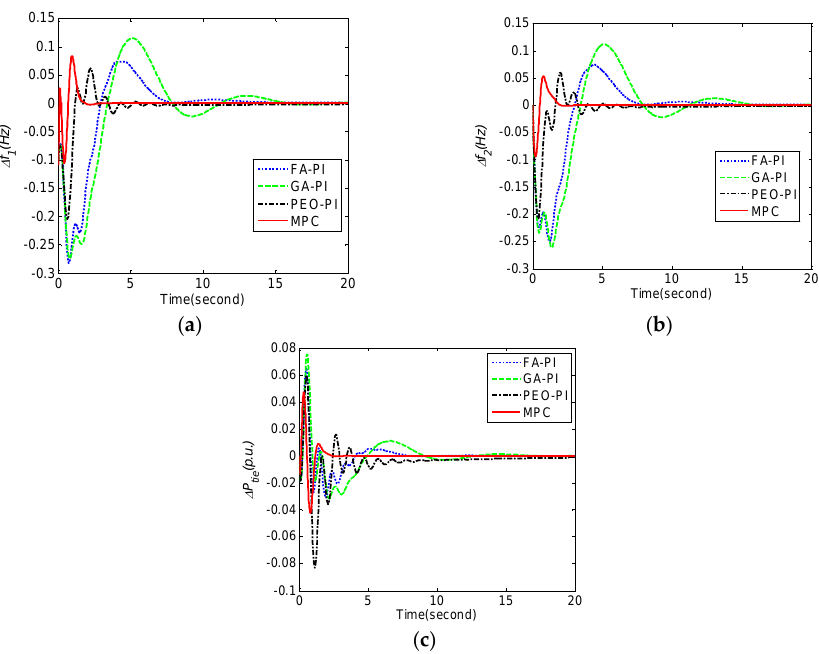
Figure 6. Comparison of frequency deviations ∆ f 1 , ∆ f 2 , and tie line power deviation ∆ P tie obtained by different control methods under T g increasing 40% for case 3. ( a ) frequency deviation ∆ f 1 ; ( b ) frequency deviation ∆ f 2 ; ( c ) tie line power deviation ∆ P tie .